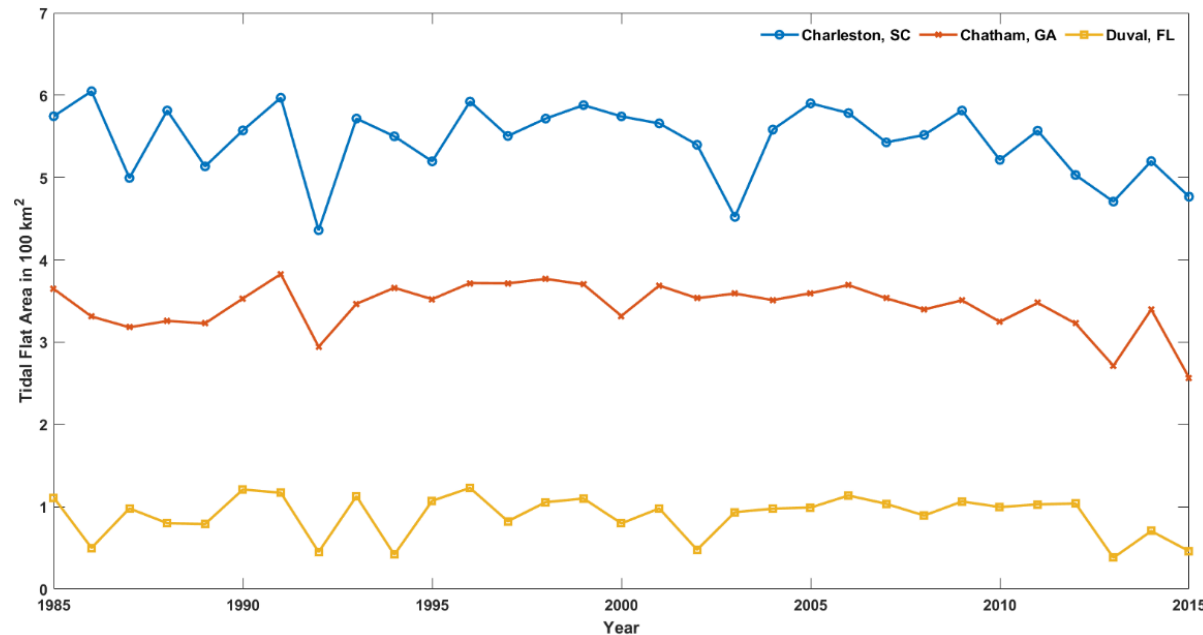
Figure 3. The annual distribution of tidal flat area in the three counties.